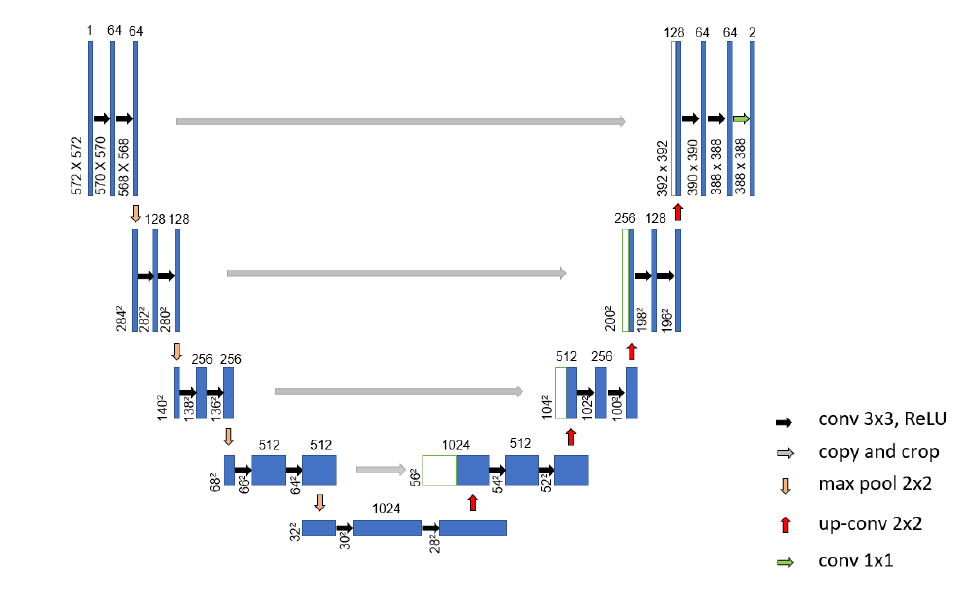
Figure 9. Architecture of the proposed U-Net network used in